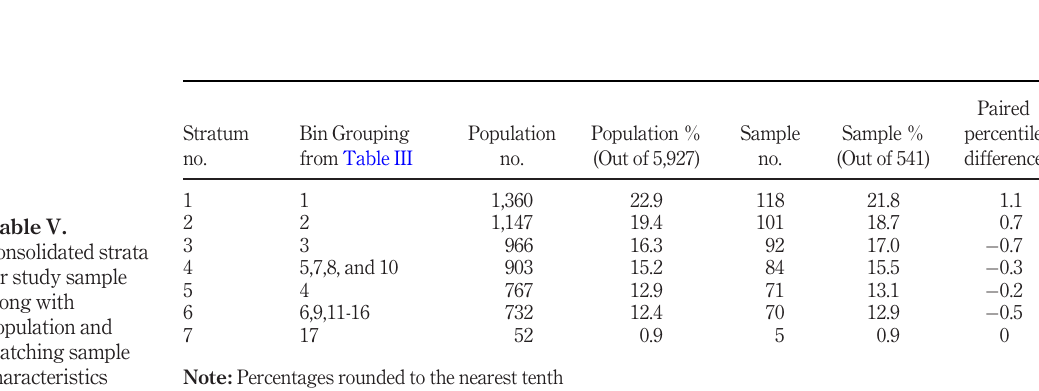
Table IV. Population breakdown of the 5,927 contracts and associated percentages